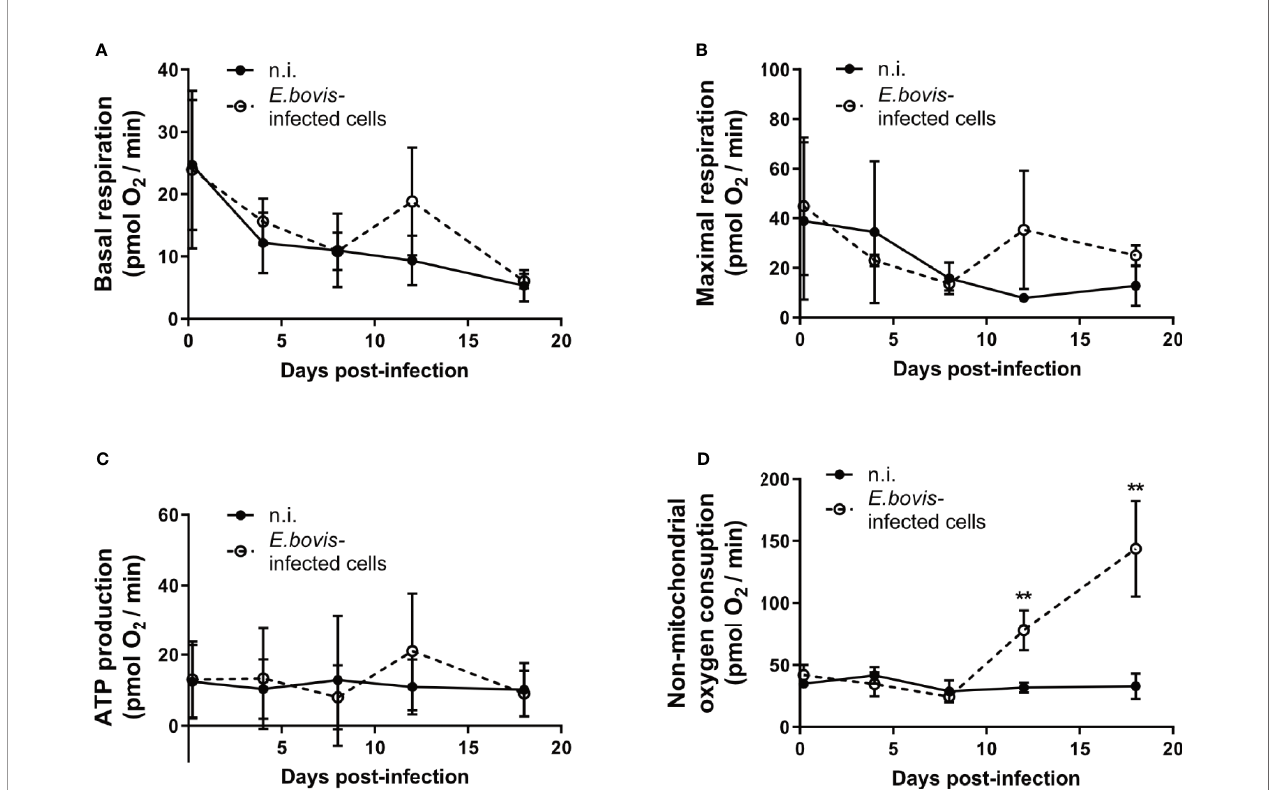
FIGURE 4 | E. bovis -driven modulation of the host cellular carbohydrate catabolism. BUVEC (n = 3) were infected with E. bovis sporozoites and tested for mitochondrial responses by a mitochondrial stress test (Agilent). After the sequential supplementation of 1 m M oligomycin, 0.5 m M FCCP, and 1 m M rotenone/ antimycin ( A ) several mitochondrial parameters were measured in E. bovis – infected ( ◌ ) and non-infected cells ( (cid:129) ) at 4 h p. i., 4, 8, 12, 18 days p. i. Based on OCR values (pmol/min), single parameters, such as basal respiration (A), maximal respiration (B) , ATP production (C) , and non-mitochondrial oxygen consumption (D) were determined. [basal respiration = (last rate measurement before the fi rst injection) − (non-mitochondrial respiration rate)]. Statistical analysis applied was a two-way ANOVA with repeated measurements de fi ning the time as the matching variable (signi fi cance de fi ned as p ≤ 0.05). Values are expressed as means ± SD of three biological replicates. ** p ≤